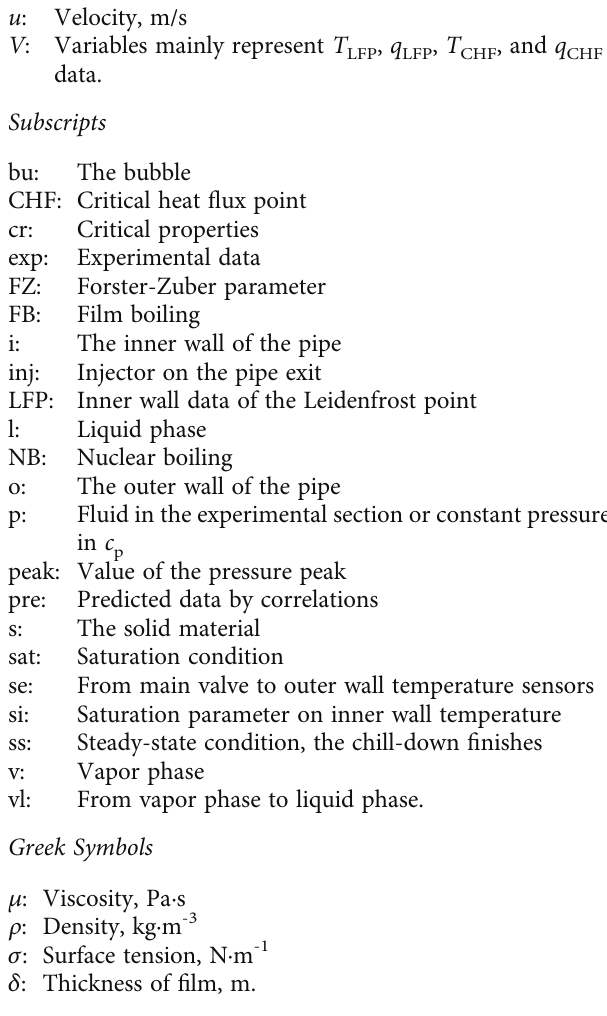
Table 2, p (pressure on CHF), q (inner wall heat fl ux CHF CHF on CHF), t (time spent from CHF to chill-down start- CHF ing), T (inner wall temperature on CHF), T (saturation CHF sat temperature corresponding to p ), and h (inner wall CHF CHF heat transfer coe ffi cient on CHF) are listed for all of the 14 points for Exp. 1 ~ 8. In this way, both vapor properties and liquid properties could be determined for these points